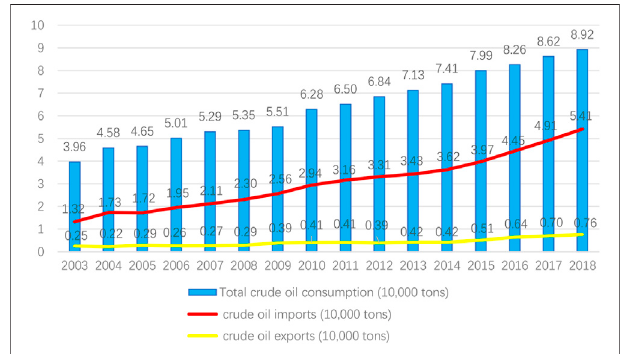
FIGURE 3 | China ’ s crude oil consumption, import and export data (2003 – 2018). Data Sources:China Statistical Yearbook 2004 – 2019.